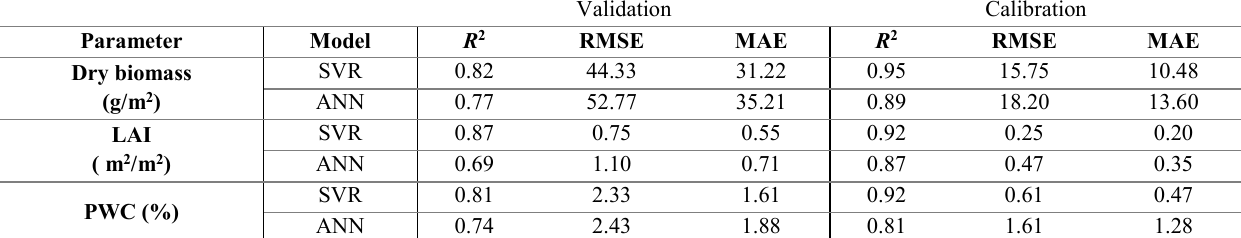
Table 1. Correlation statistics of measured and estimated total dry biomass, LAI, and PWC using ANN and SVR